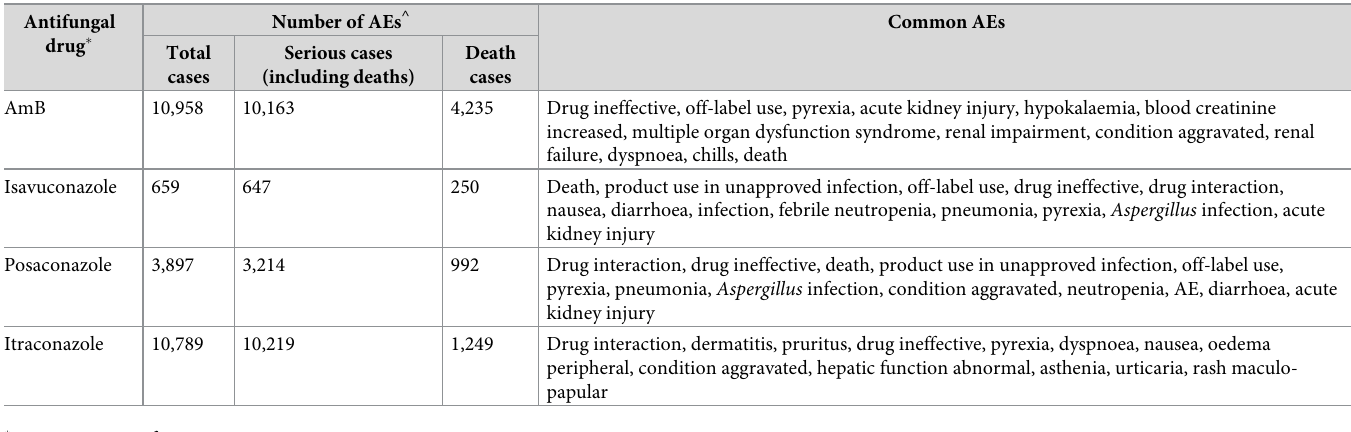
Table 2. Common AEs of systemic fungal agents used to treat CAM as reported in the US Food and Drugs Administration Adverse Events Reporting System [85]. Antifungal drug